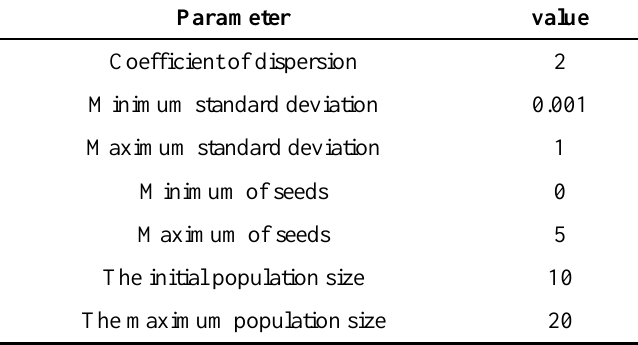
Table 2. Parameters used in the IWO algorithm